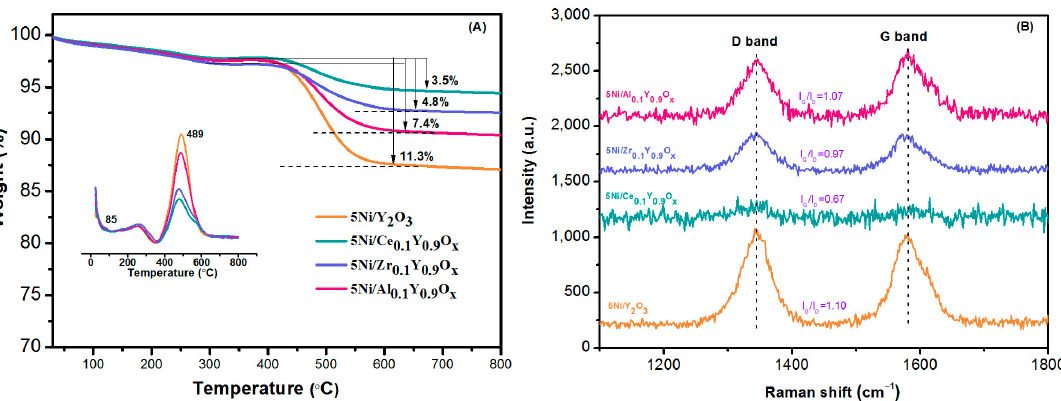
Figure 4. Carbon deposit analysis of the catalysts after 50 h tests at 750 °C for DRM: ( A ) TGA-DSC profiles; ( B ) Raman spectra.